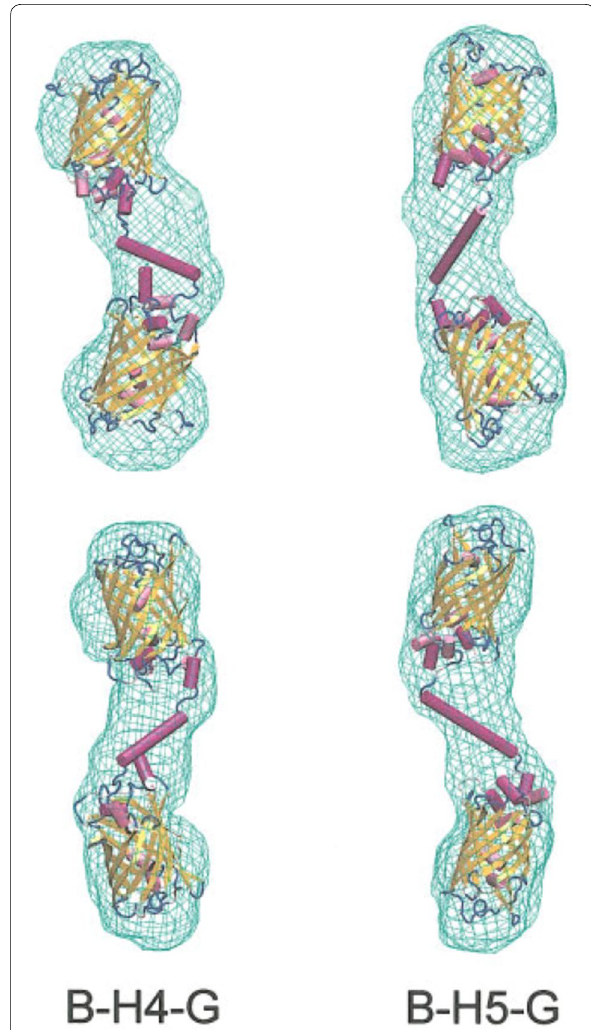
Fig. 29 High-resolution models (cartoon representation) of the EBFP and EGFP connected with the helical linkers. B–H4–G and B–H5–G indicate EBFP–LA(EA 3 K) n AAA–EGFP (n 4, 5), respectively. Low-res- = olution models based on only SAXS data are shown as wire-frames. The linker and the two domains are modeled and two different views are shown (Figure reproduced with permission from: Ref. [347]. Copy- right (2004) John Wiley &